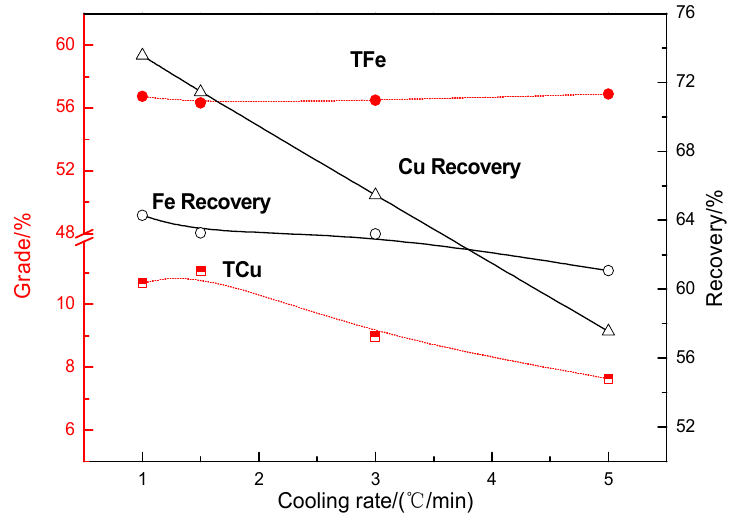
Figure 8. Effects of slow cooling rate on recovering of copper and iron (0.45 of binary basicity, blending with 12% of compound additive, modifying at 1350 °C for 120 min and cooling down to 900 °C).